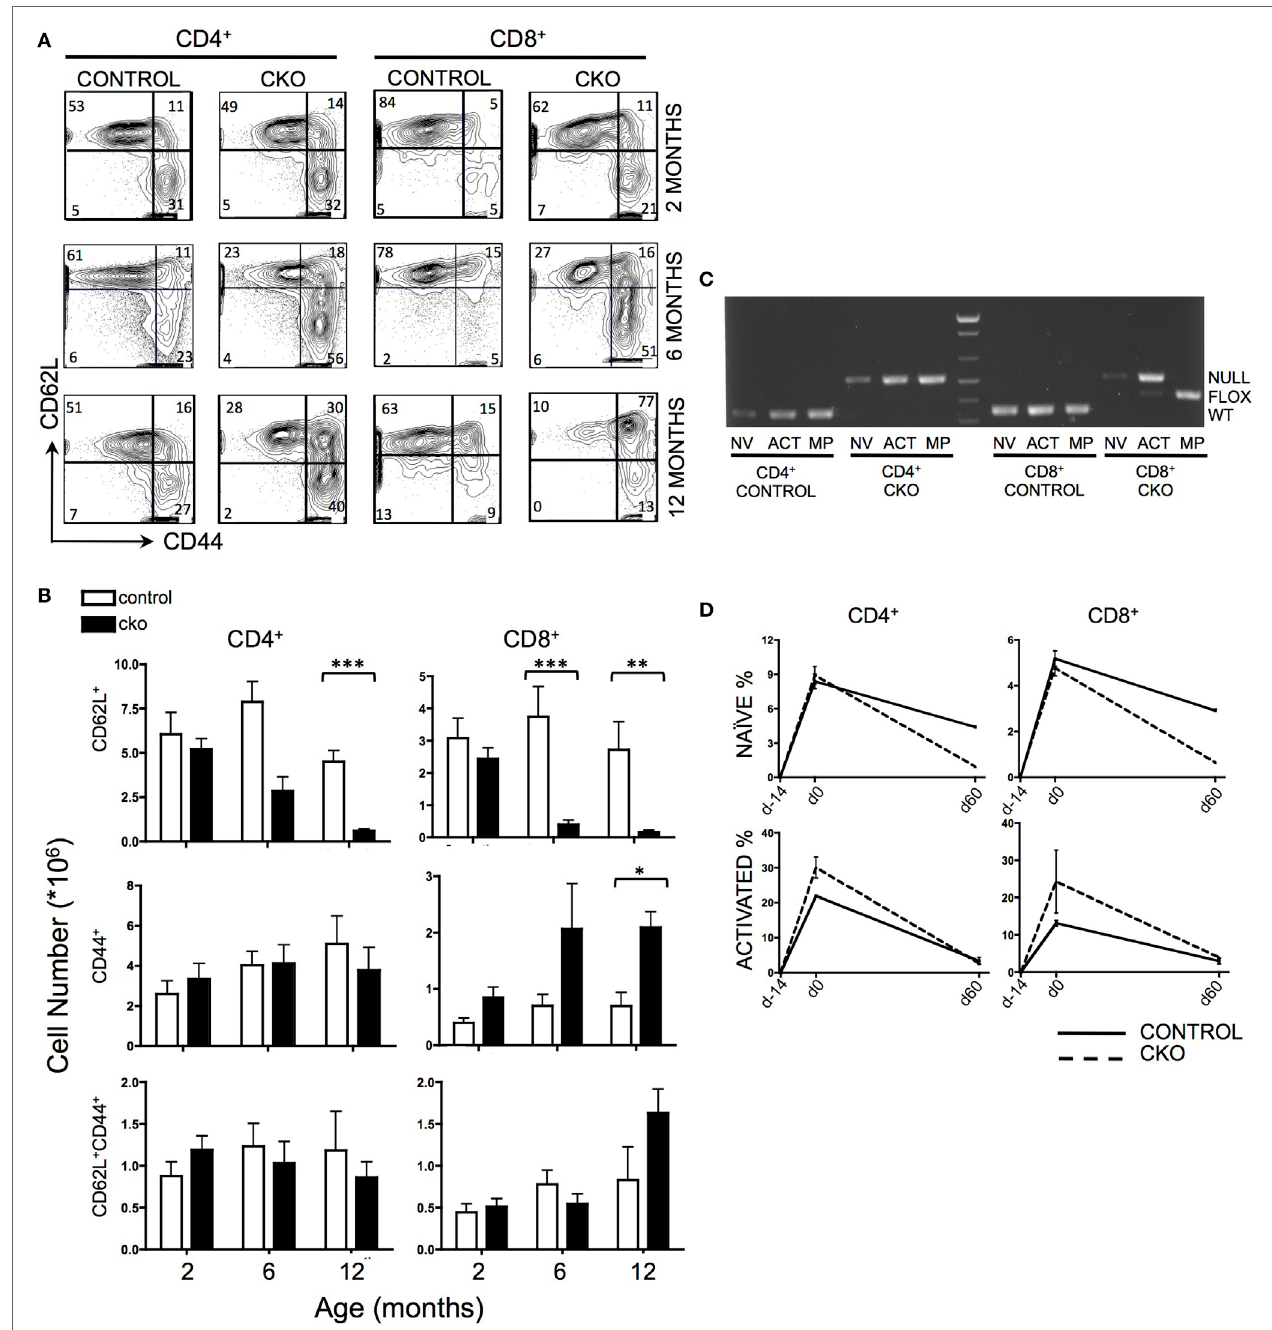
FigUre 1 | Zfx deletion causes a time-dependent loss of naïve peripheral T cells, and an accumulation of Zfx “non-deleters.” (a) Splenic T cell populations in control and conditional knockout (CKO) mice over time. Shown are FACS profiles of splenic T cell CD62L and CD44 expression from mice of the indicated ages. Numbers represent percentage of cells in each gate. Plots are representative of over five independent experiments. (B) Summary of T cell population numbers in control and CKO mice over time. The plots show absolute number ± SEM of each indicated splenic T cell population in control and CKO mice at 2 months ( n = 8–10), 6 months ( n = 5–7), and 12 months ( n = 2–3) of age. Statistically significant differences are indicated as follows: *** P < 0.001; ** P < 0.01; * P < 0.05. (c) PCR of Zfx allele in splenic T cells of 10-month-old mice. Shown is a PCR that detects the presence of a deleted (top band) or floxed non-deleted (bottom band) Zfx allele from FACS-sorted T cell populations. NV = naïve (CD62L + ), ACT = activated (CD44 + ), MP = memory phenotype (CD62L + CD44 + ). (D) Formation and loss of peripheral T cells over time. Control and CKO mice (less than 3 months of age) were injected intraperitoneally with bromodeoxyuridine (BrdU) and then administered BrdU in their drinking water for 14 days, followed by removal of BrdU for 60 days. Shown are the percentages of CD62L + naïve and CD44 + activated BrdU + T lymphocytes in the spleen. The values represent percentage of BrdU + cells ± SEM for two mice at each timepoint. Plots are representative of three independent